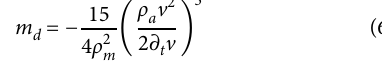
c = 1, the dynamic mass m d